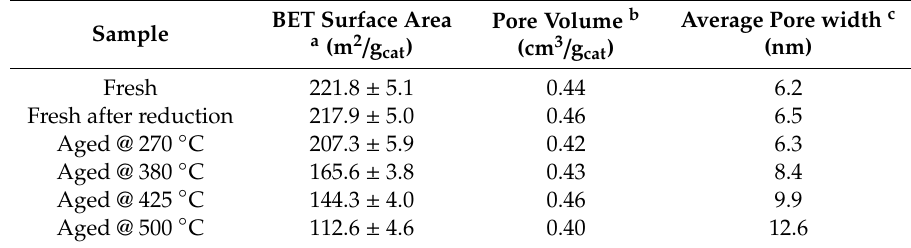
Table 2. Surface area and average pore width.